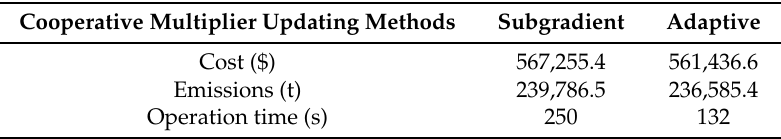
Table 2. The effects of coordinating multipliers updating method on smart grid.